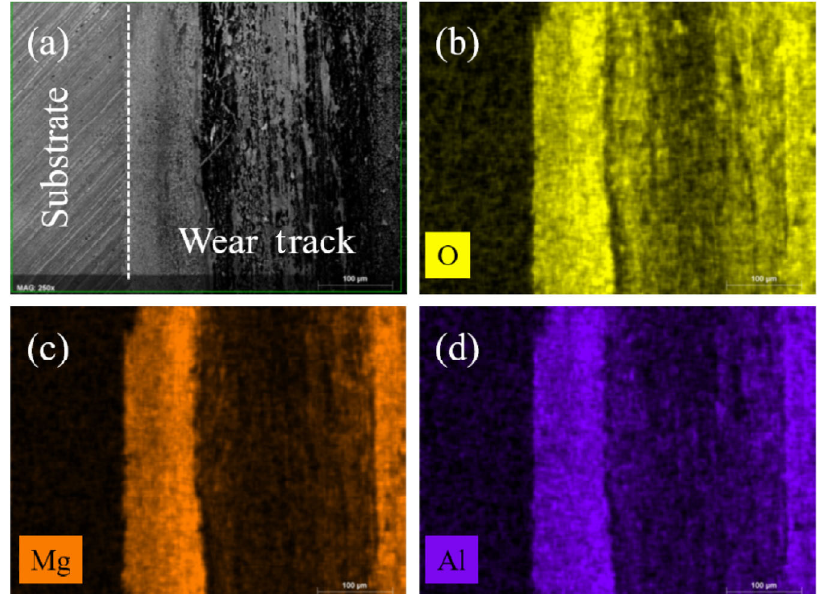
Fig. 7 (a) SEM image and (b) oxygen, (c) magnesium and (d) aluminum distribution of wear track lubricated by 1 wt% flower-like LDH in base